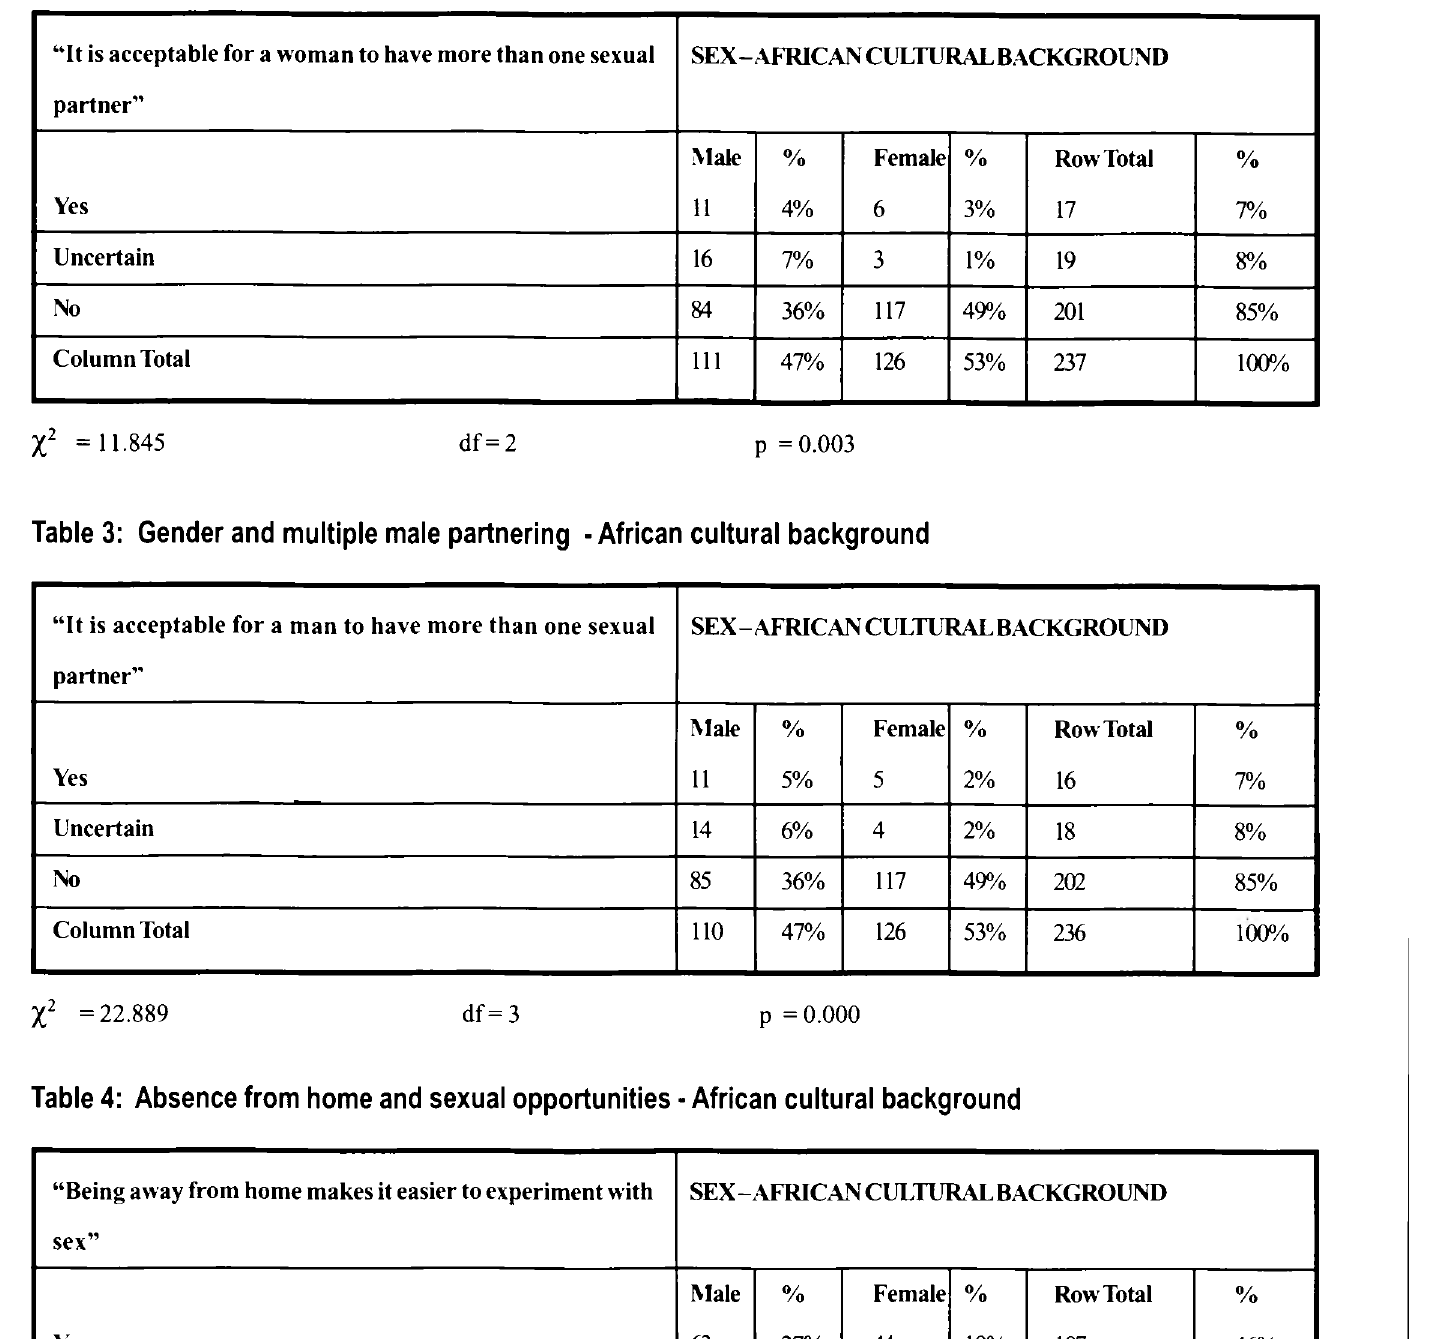
Table 2: Gender and multiple female partnering - African cultural background “It is acceptable for a woman to have more than one sexual partner”